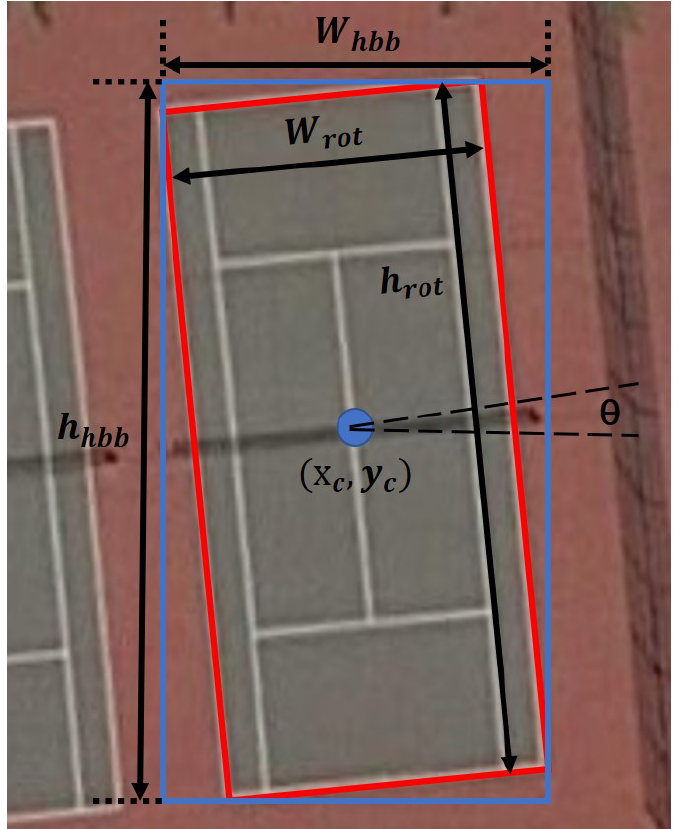
Figure 4. Illustration of the elements predicted by RPN. The horizontal bounding box and the oriented bounding box are highlighted in blue and red, respectively. The horizontal bounding box is represented as x c , y c , w hbb and h hbb , denoting respectively the center coordinates, the width and the height of the box. Meanwhile, w rot , h rot and θ denote the width, height and rotational angle of the rotated box, respectively. As the center coordinates of HBB and OBB are the same, the center coordinates will be shared in